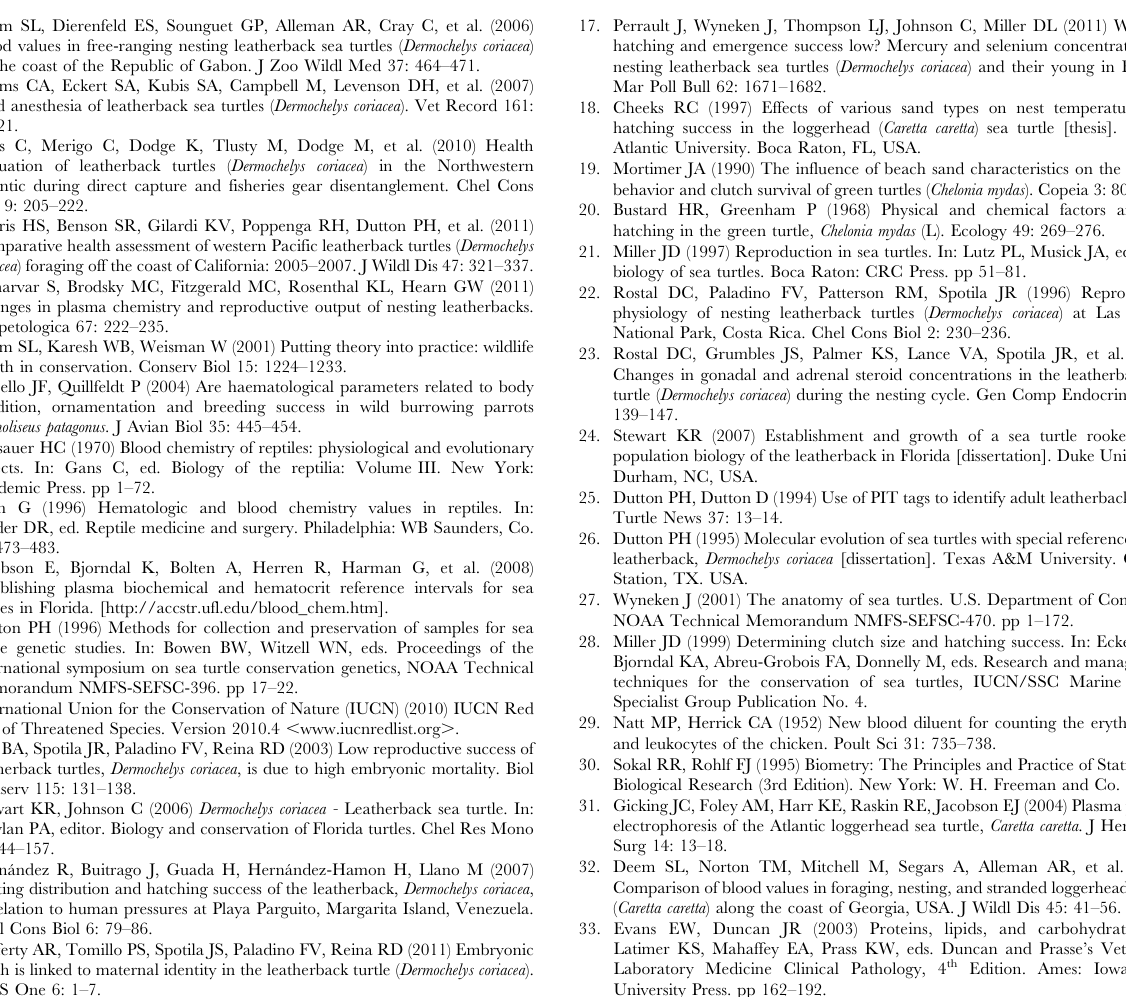
Table S3 Synopsis of plasma biochemical data for leatherback sea turtles from the literature (eastern Atlantic Ocean). Table S4 Synopsis of plasma biochemical data for leatherback sea turtles from the literature (Pacific